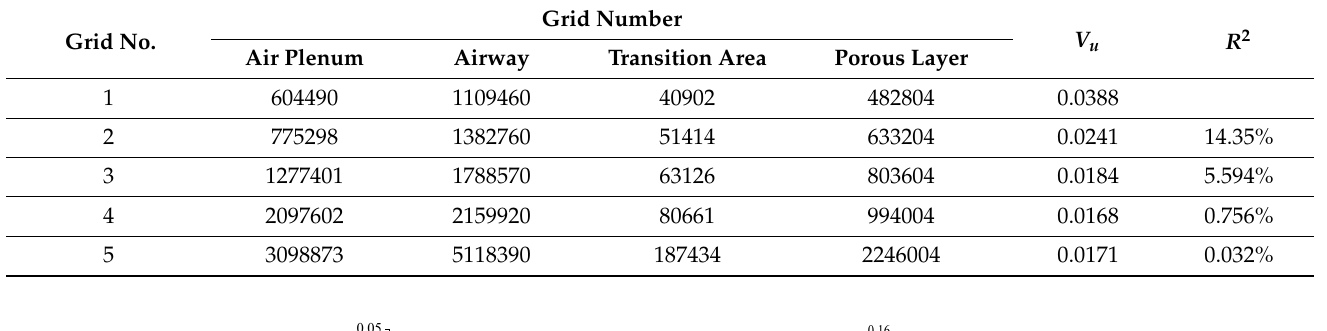
Table 3. Grid independence validation.